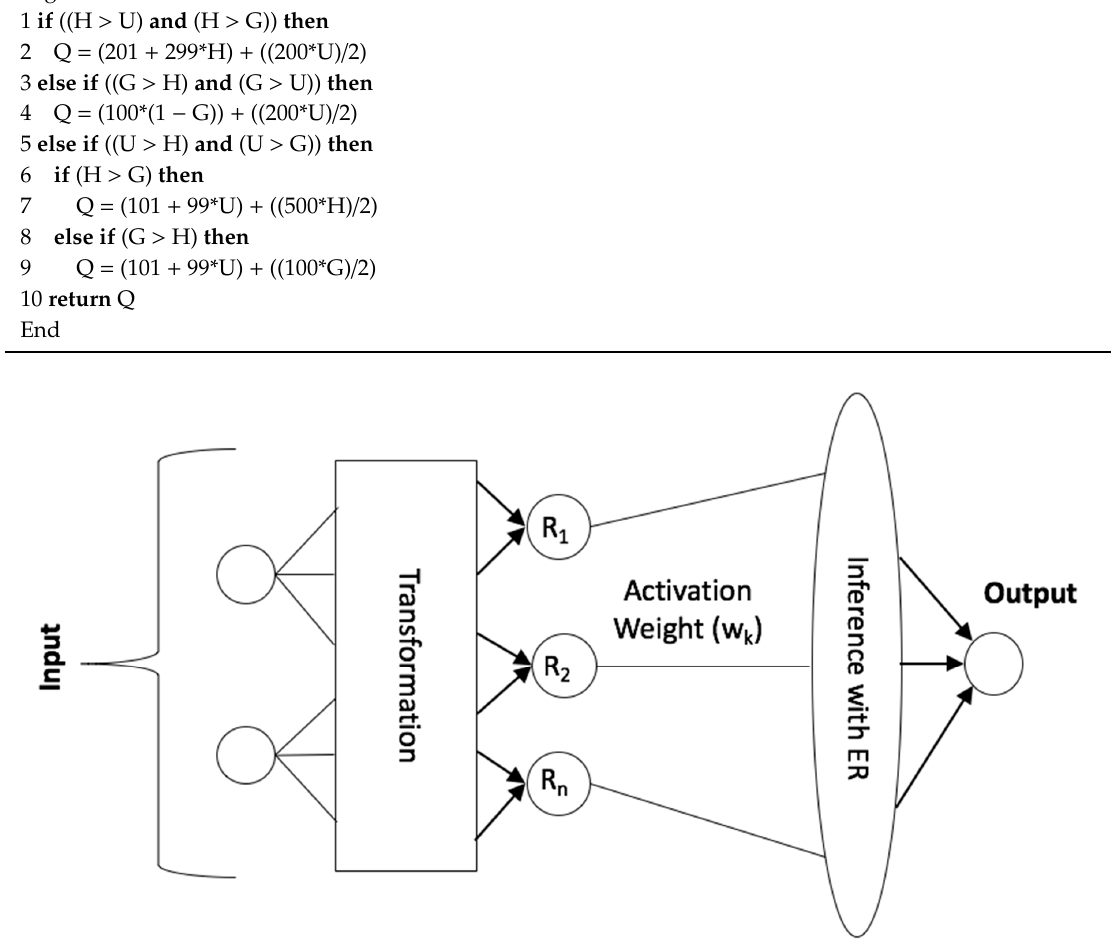
Figure 3. Conceptual architecture of Belief Rule Based Expert System (BRBES).